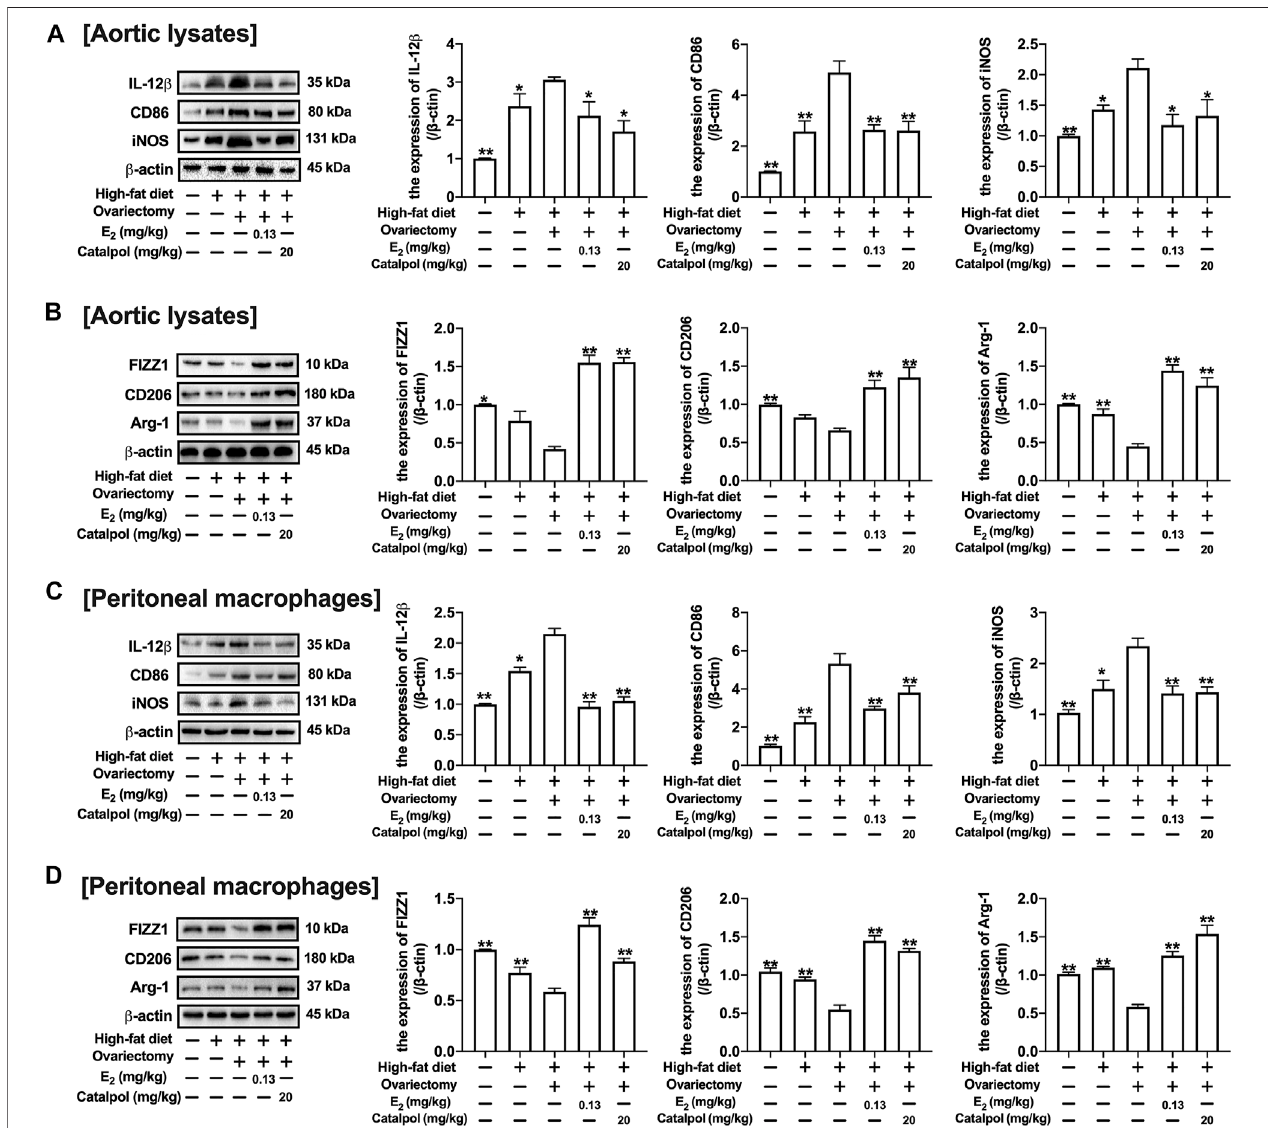
FIGURE 8 | Catalpol attenuated the expression of M1 macrophage markers in HFD-Ovx-treated ApoE − / − mice. (A) Effects of catalpol on the expressions of M1 macrophage markers (IL-12 β , CD86 and iNOS) in aortic macrophages ( n (cid:2) 3); (B) Effects of catalpol on the expressions of M2 macrophage markers (FIZZ, CD206 and Arg-1)inaortic macrophages ( n (cid:2) 3); (C) Effects ofcatalpol ontheexpressionsofM1macrophage markers(IL-12 β ,CD86, andiNOS) inperitonealmacrophages ( n (cid:2) 3); (D) EffectsofcatalpolontheexpressionsofM2macrophagemarkers(FIZZ1,CD206,andArg-1)inperitonealmacrophages( n (cid:2) 3).Dataareexpressedasmean ± SD. * p < 0.05, ** p < 0.01 vs. Ovx